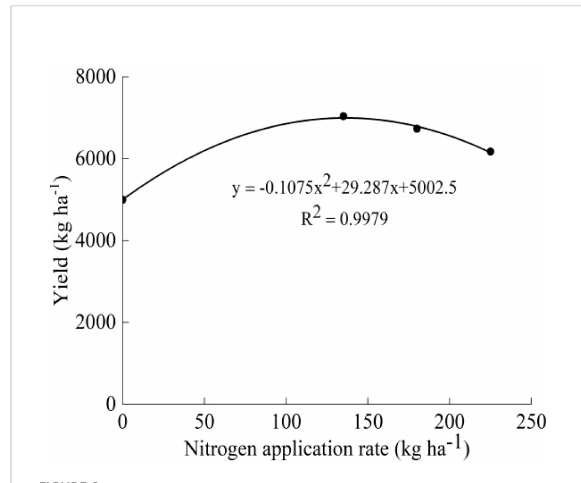
FIGURE 2 Relationship between J20 yield and nitrogen application